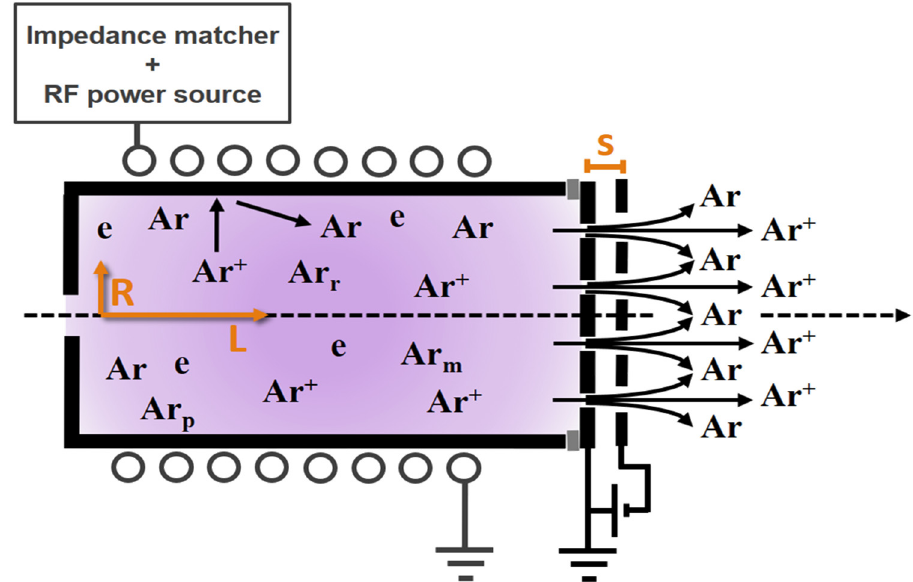
Figure 1. Schematic of the plasma thruster with grids, surrounded by a RF coil at 13.56 MHz. Argon gas is injected on the left and positive ions are accelerated by DC biased grids on the right.